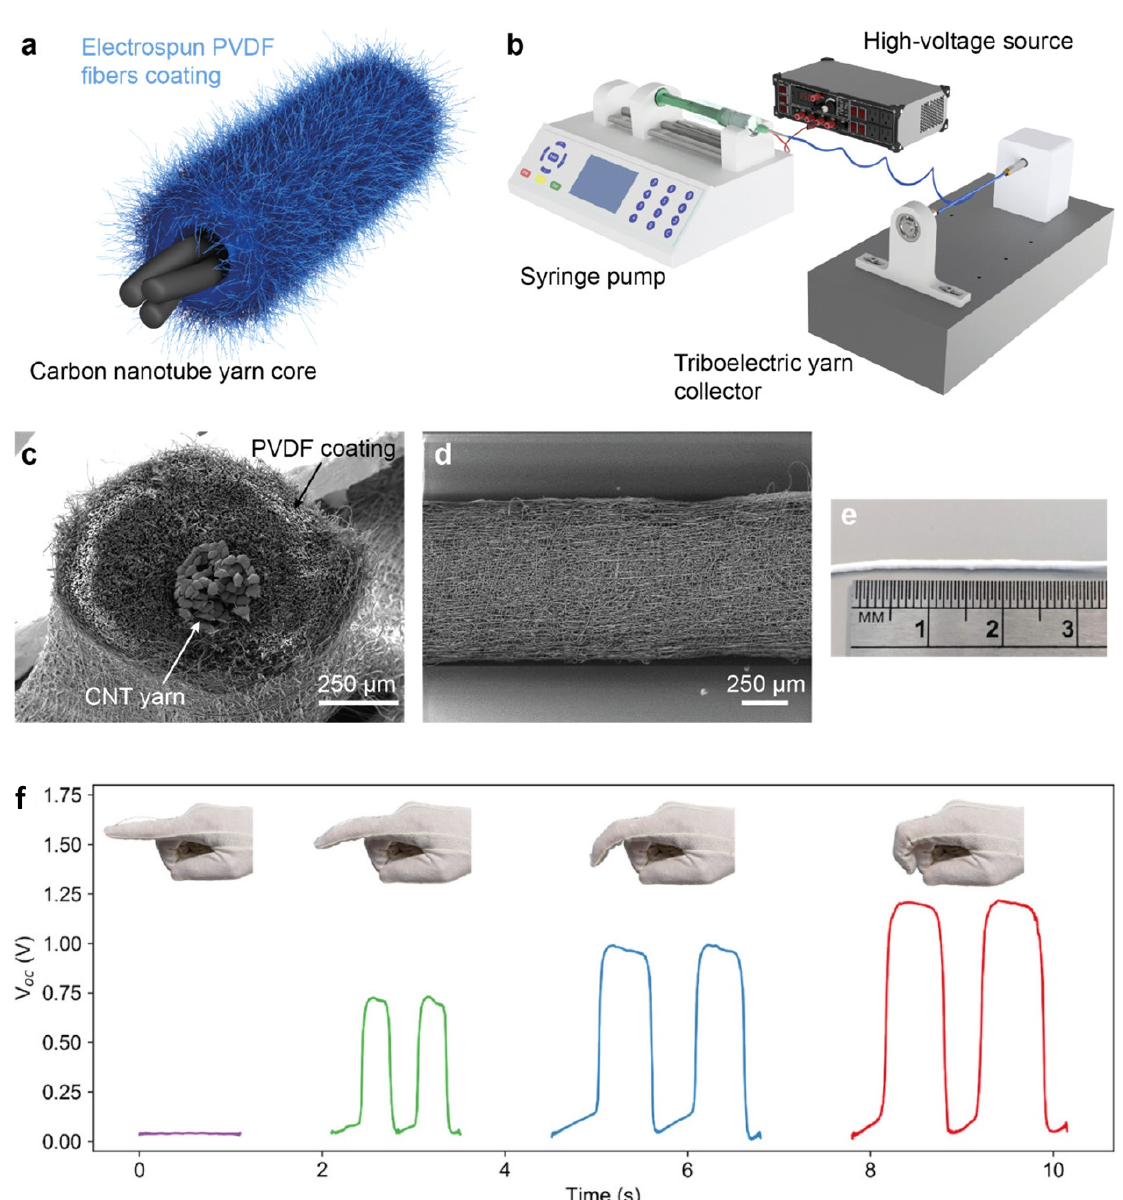
Figure 7. Triboelectric core–shell structure of yarns: ( a ) scheme of the yarn; ( b ) fabrication setup of yarn, including electrospinning setup and rotating collector; ( c , d ) SEM micrographs of the cross section and along the yarn; ( e ) image of triboelectric yarn above the ruler; ( f ) demonstration of the triboelectric yarn in a glove with the output measured as the haptic potential. The yarn (5 cm in length) was attached to the index finger of the glove. All figures are reproduced from [73] under the terms and conditions of an open access CC-BY license agreement.